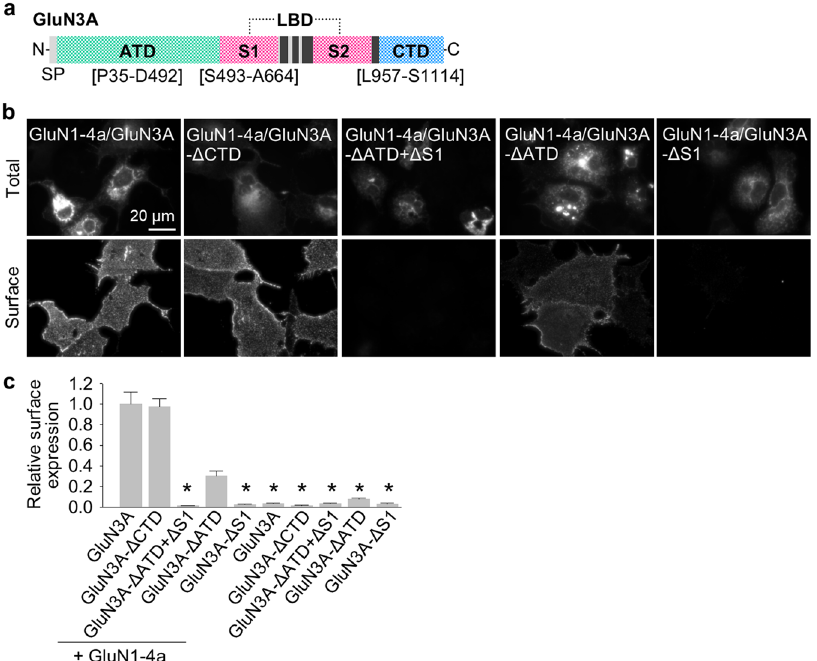
Figure 1. The S1 segment in the GluN3A subunit is essential for the surface expression of GluN1/GluN3A receptors. (a) Schematic diagram of the GluN3A subunit, with the amino-terminal domain (ATD), ligand- binding domain (LBD) composed of S1 and S2 segments, and C-terminal domain (CTD) indicated; the black rectangles indicate membrane domains. (b) Representative images of total and surface GluN1-4a/GFP-GluN3A receptors lacking the indicated domains in the GluN3A subunit expressed in COS-7 cells and labelled 24 h after transfection. (c) Summary of the relative surface expression of the indicated GluN subunits measured using fluorescence microscopy (n ≥ 20 cells per group); * p < 0.05 vs. GluN1-4a/GluN3A